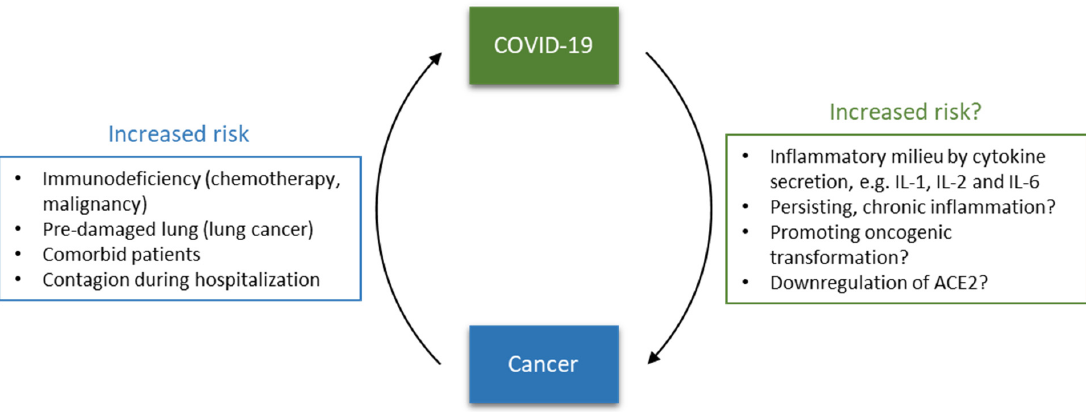
Figure 1. Bidirectional relationship between coronavirus disease 2019 (COVID-19) and cancer.